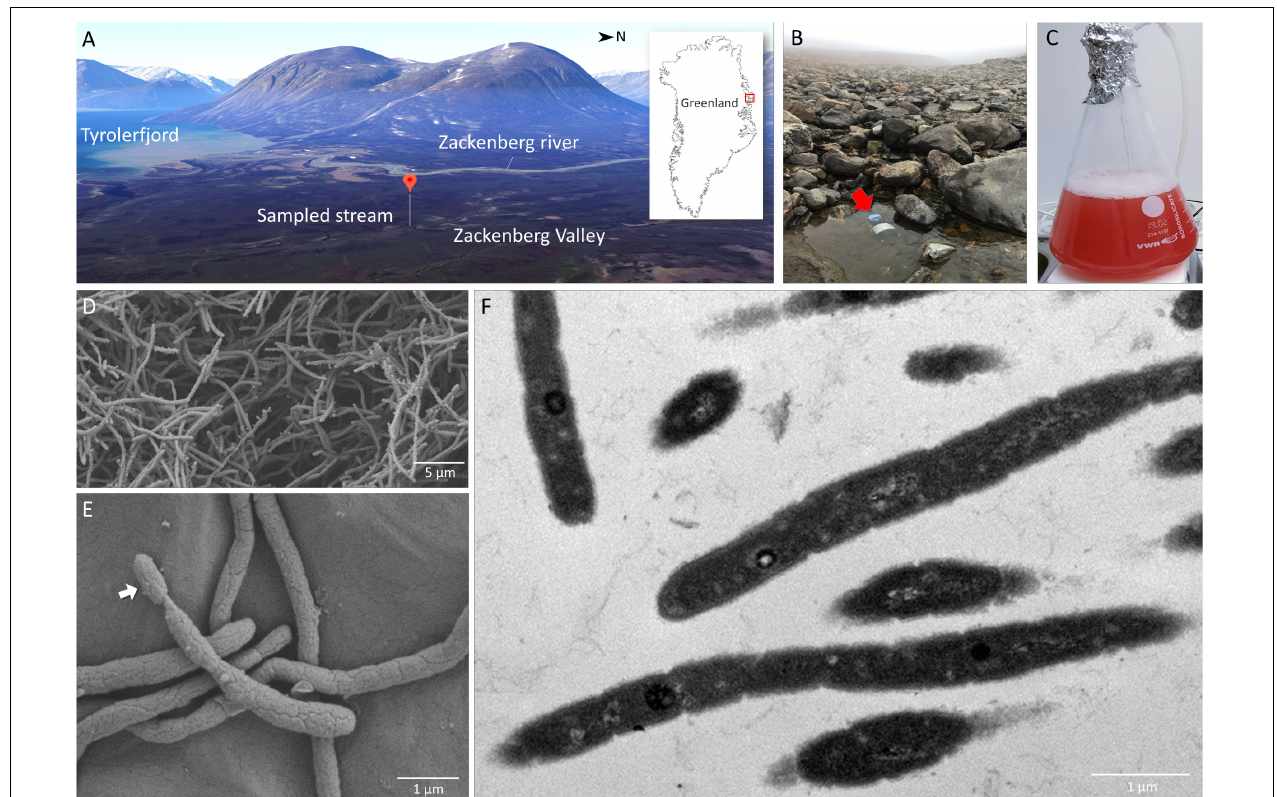
FIGURE 1 | Sampling site at a stream near the Zackenberg Research Station in Northeast Greenland (A,B) , 2-week old pure culture of Gemmatimonas groenlandica strain TET16 T aerobically grown in a liquid medium (C) and microscopic images of the TET16 T cells ( D,E – scanning electron microscopy; F – transmission electron microscopy). The 3D map view of the Zackenberg Valley facing the West was generated from Google Maps.